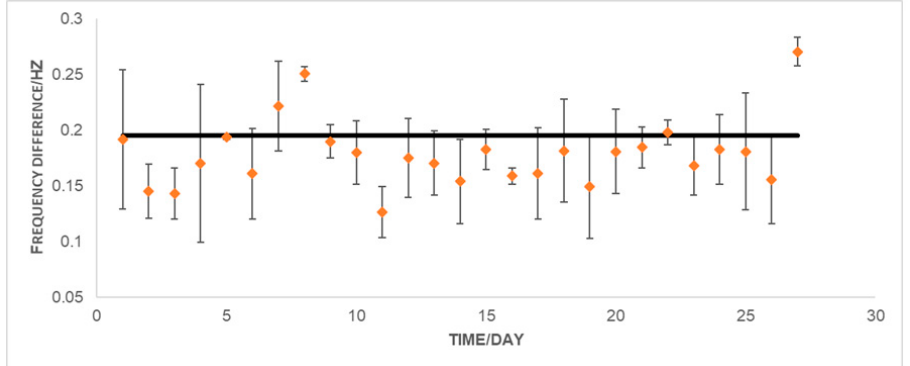
Figure 11. The mean of the frequency difference between two optical clocks located at two sites. Each orange point shows the frequency difference mean value between two optical clocks in one day, and gray vertical lines are the statistical uncertainty. The black horizontal line is the weighted mean.